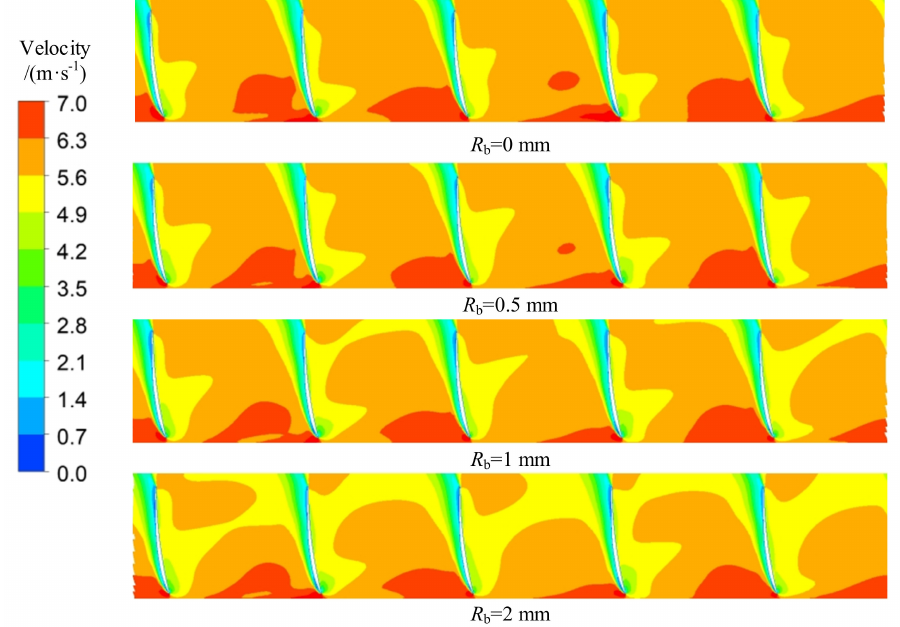
Figure 16. Distribution of velocity in cylindrical section of the guide vane under different R b at 1.0 Q des ( Span =